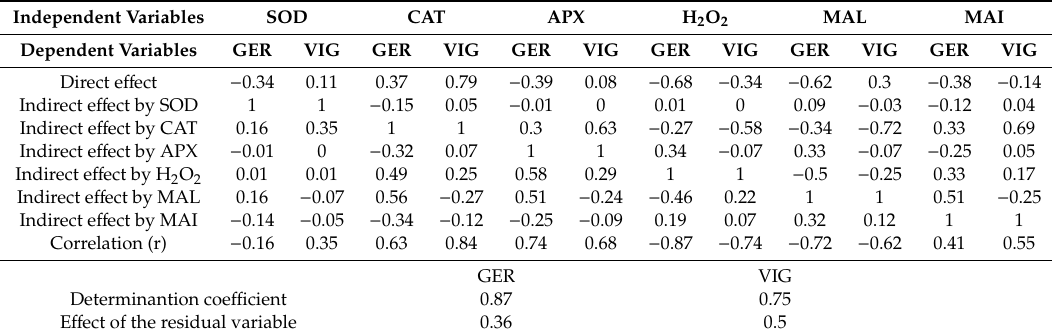
Table 1. Estimates of direct and indirect e ff ects involving the key dependent variables of germination and vigor, and the other independent explanatory variables as antioxidant enzymes, hydrogen peroxide, malondialdehyde, and Maillard reaction.